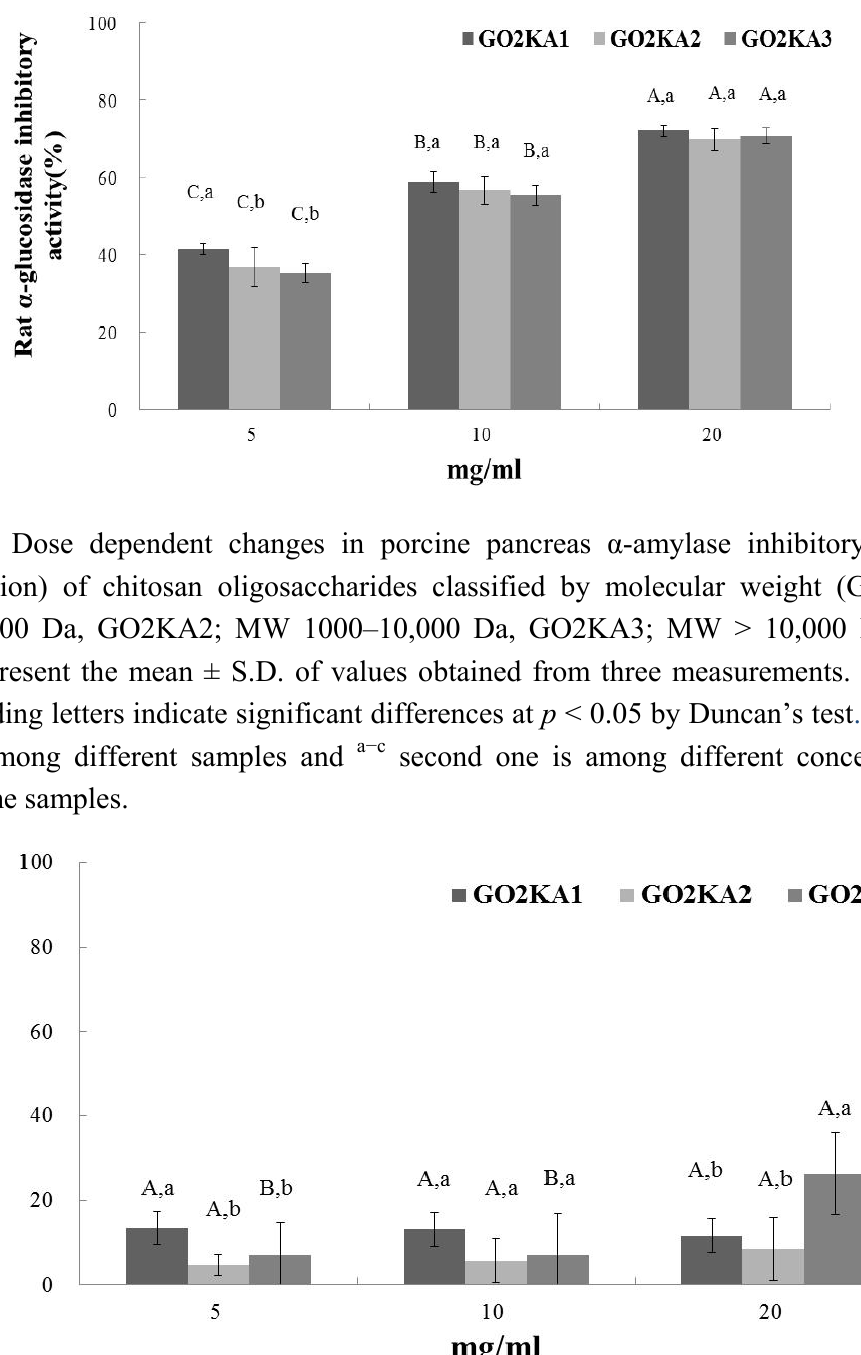
Figure 1. Dose dependent changes in rat intestinal α -glucosidase inhibitory activity (% inhibition) of chitosan oligosaccharides classified by molecular weight (GO2KA1; MW < 1000 Da, GO2KA2; MW 1000–10,000 Da, GO2KA3; MW > 10,000 Da). The results represent the mean ± S.D. of values obtained from three measurements. Different corresponding letters indicate significant differences at p < 0.05 by Duncan’s test. A − C First letter is among different samples and a − c second one is among different concentrations within same samples.